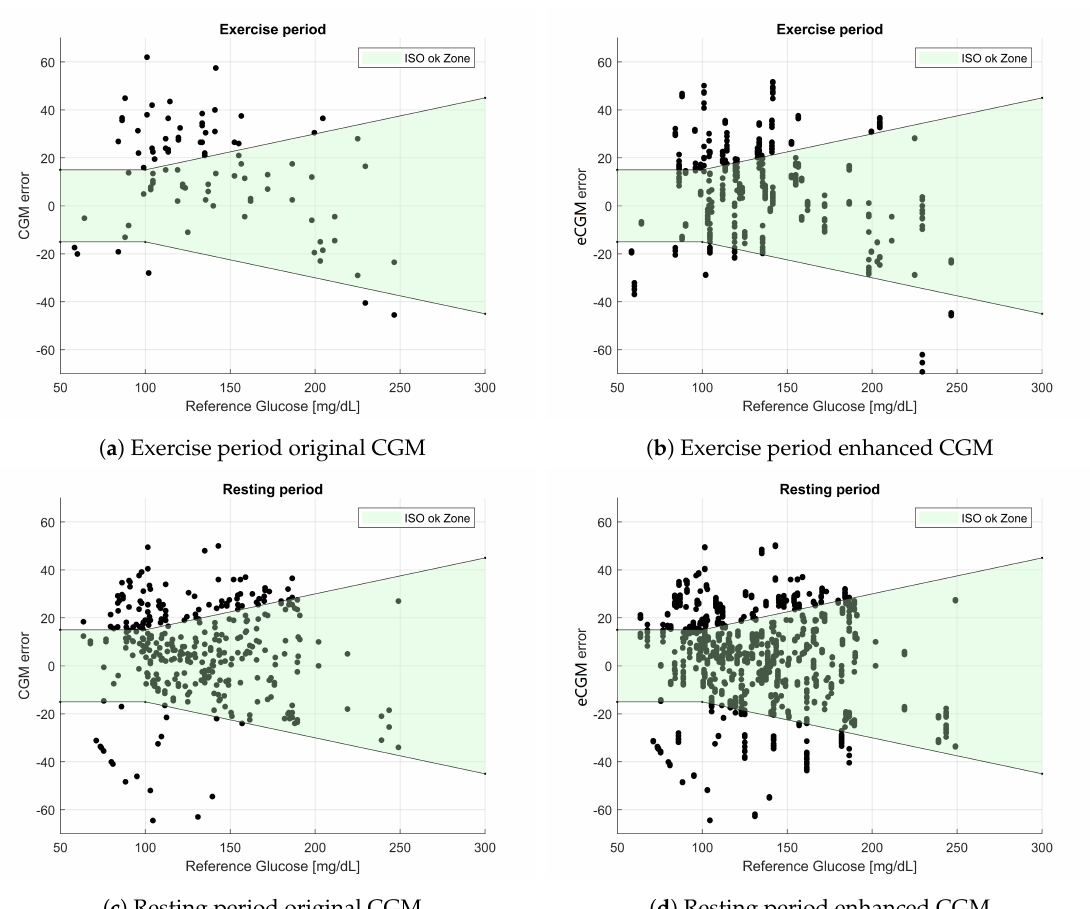
Figure 5. ISO acceptable region for the wearable-enhanced CGM errors. ( a ) Subset of error-YSI pairs before enhancement during the physical activity period. ( b ) Subset of error-YSI pairs after enhancement with exercise monitoring devices during the physical activity period. ( c ) Subset of error-YSI pairs before enhancement during the resting period. ( d ) Subset of error-YSI pairs after enhancement with exercise monitoring devices during the resting